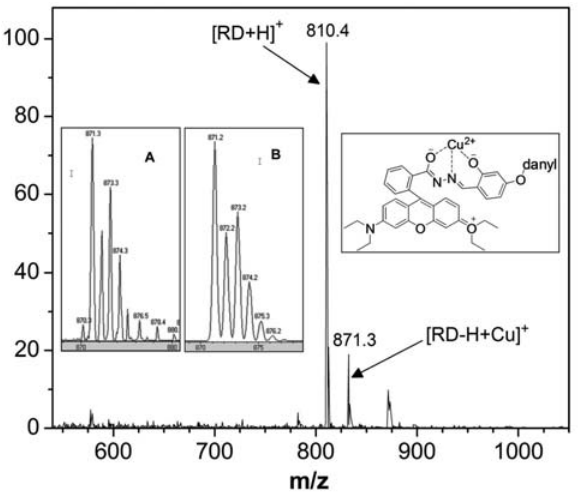
Figure 10. ESI-MS spectrum of RD in the presence of Cu(NO Inset: observed (A) and calculated (B) isotopic patterns for [ RD - H+Cu ] + , and the proposed coordination pattern of RD -Cu2+ com-